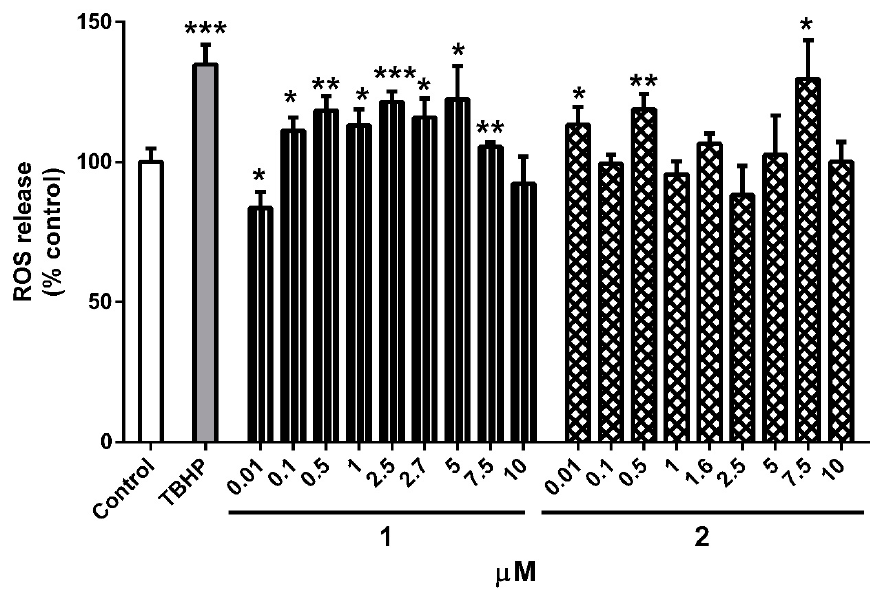
Figure 6. Effect of 1 and 2 on ROS levels in human neuroblastoma cells. Compounds (0.01–10 µM) were added to the cells for 24 h. The fluorescent dye carboxy-H 2 DCFDA was used to evaluate reactive oxygen species (ROS) production. tert-butyl hydroperoxide (TBHP) at 75 µM was used as a positive control. Mean ± SEM of three independent experiments. Data are expressed as a percentage of control cells. Statistical differences between treatments and control cells were determined with Student’s t test. * p < 0.05, ** p < 0.01, *** p < 0.001.